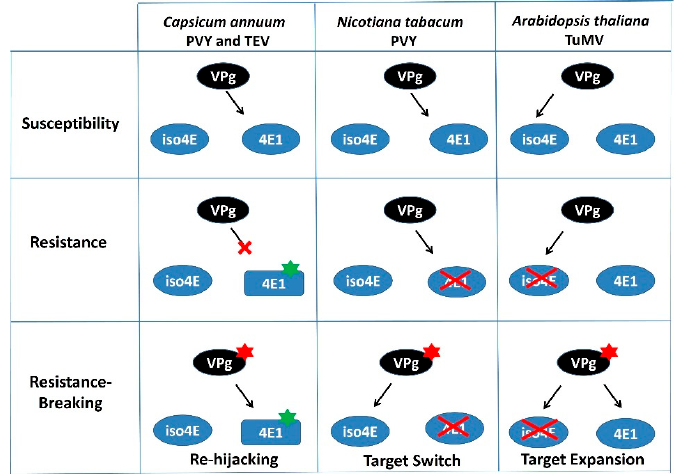
Figure 2. Different Resistance-Breaking pathways for potyviruses in plants. Potyviruses are represented by their VPg (main virulent determinant for eIF4E-mediated resistance). Two plant translation initiation factors are represented: eIF4E1 (4E1) and its isoform eIFiso4E (iso4E). Mutations affecting eIF4E1 or the viral VPg are represented by green and red stars, respectively. KO mutants for eIF4E or eIFiso4E are crossed out. The figure is a schematic representation of resistance-breaking strategies in Capsicum annuum , Nicotiana tabacum and Arabidopsis thaliana as depicted in References [85,87,88], respectively. Briefly, in Capsicum annuum , mutation in the viral VPg allows the virus to hijack the resistant eIF4E1 protein; in Nicotiana benthamiana , it allows the virus to recruit eIFiso4E while losing its initial ability to